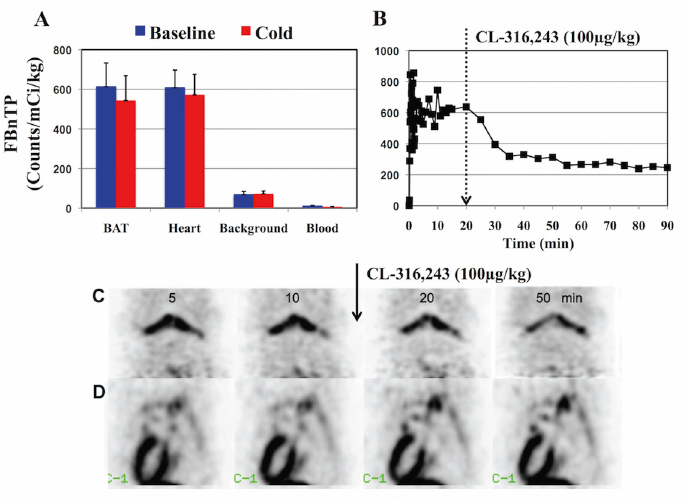
Fig 5. Noradrenergic Mediation of 18 F-FBnTP Washout Response. (A) Effect of propranolol 18 F-FBnTP- washout response to cold stimulation. Propranolol blocked cold-induced 18 F-FBnTP washout from BAT. A slight but insignificant decrease (9.6% ± 11.6%; P < 0.21) was measured. (B) Effect of the ß3-AR agonist CL- 316,243 on 18 F-FBnTP retention in BAT. Administration of CL-316,243 (100 μ g, IV) resulted in 18 F-FBnTP washout from BAT with kinetics similar to those observed during cold stimulation. (C) 18 F-FBnTP PET imaged of BAT before and after administration of CL-316,243. Both PET images in (C) and time activity curve in (B) were taken form same rat ’ s BAT. Note the CL-316,243-induced washout kinetics, which are similar to those observed during localized skin cooling. (D) CL-316,243 hardly affected 18 F-FBnTP retention in heart